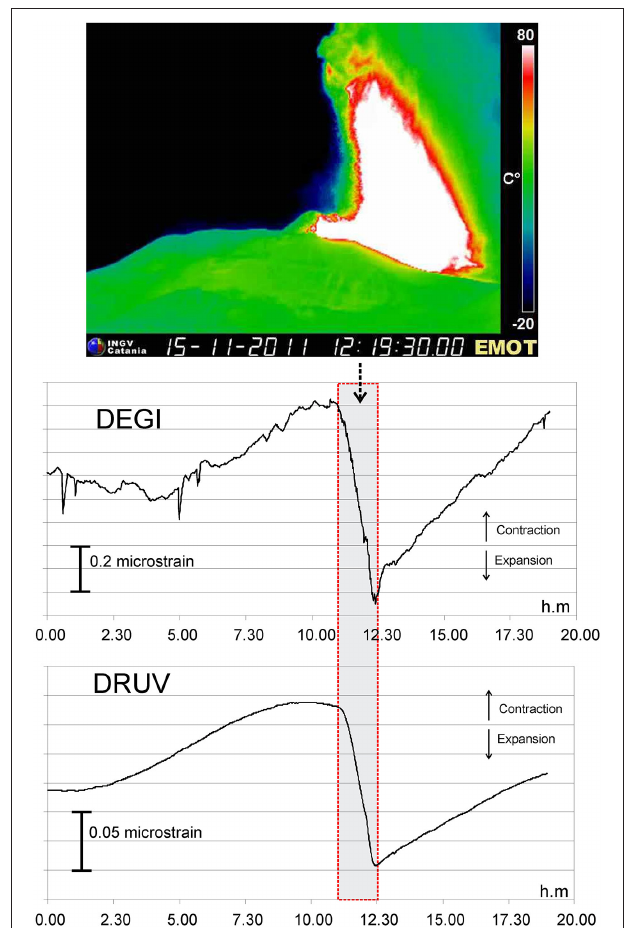
FIGURE 2 | Strain signals recorded at DEGI and DRUV during the lava fountain on 15 November 2011, just 2 weeks after the strain-meters installation. A decreasing signal is recorded during expansion and an increasing signal during contraction of the medium surrounding the instrument. The negative variation at both occurs markedly from the beginning (11:06 UT) to the end (12:30 UT) of lava fountain activity. The gray box marks the duration of the lava fountain., In the upper part a frame from the thermal cam of Montagnola (southern flank, 2700m a.s.l.) is shown.